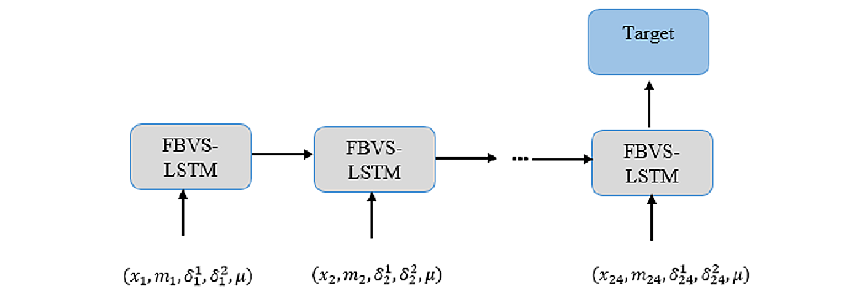
Figure 5. The general architecture of FBVS-LSTM units. Table 2. Parameter